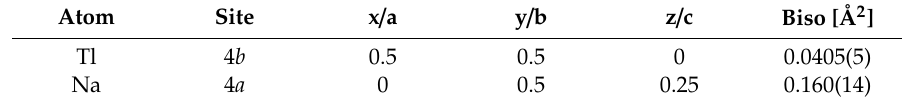
Table 3. Atom positions, crystallographic sites, and Biso [Å 2 ] of the atoms in tetragonal sodium thallide.